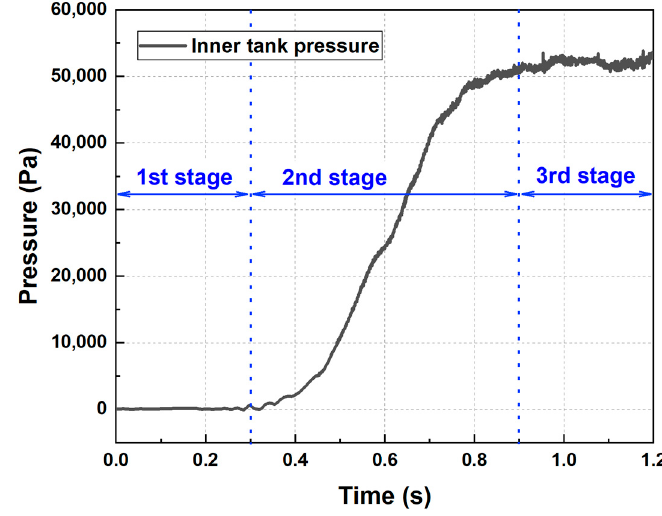
Figure 10. Variation in the inner tank pressure.